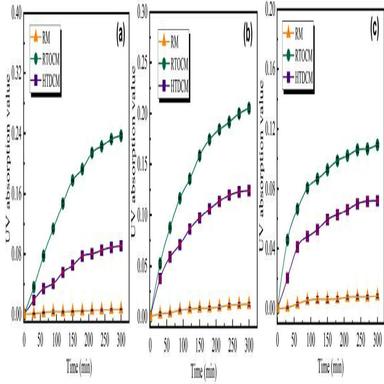
Temporal variations in the absorbance of RM, RTOCM and HTDCM in different test solutions: (a) 95 ◦C pure water; (b) 0.1 M NaOH and (c) 0.1 M HCI.